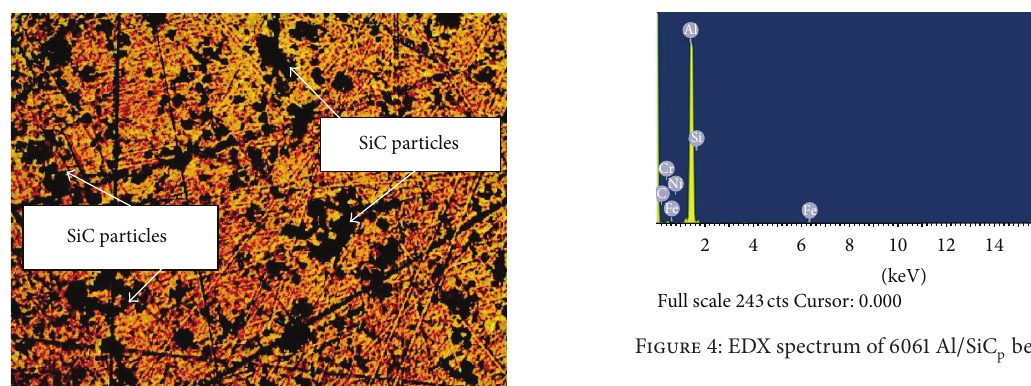
before machining. p